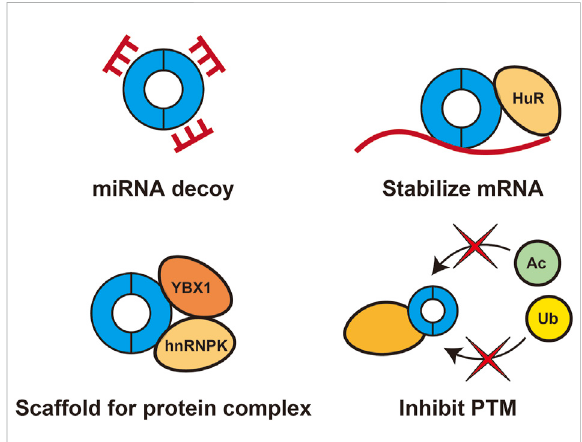
FIGURE 1 Roles of pathogenic circRNAs in pancreatic cancerPathogenic circRNAs in pancreatic cancer function as miRNA decoysand interactwith proteinsto stabilizemRNA,inhibit post-translational modi fi cations (PTMs), and provide scaffolds for protein complex